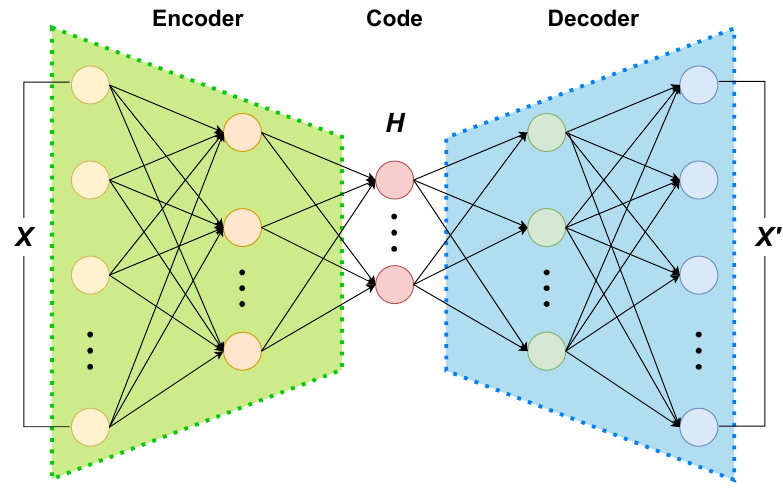
Figure 5. The structure of a